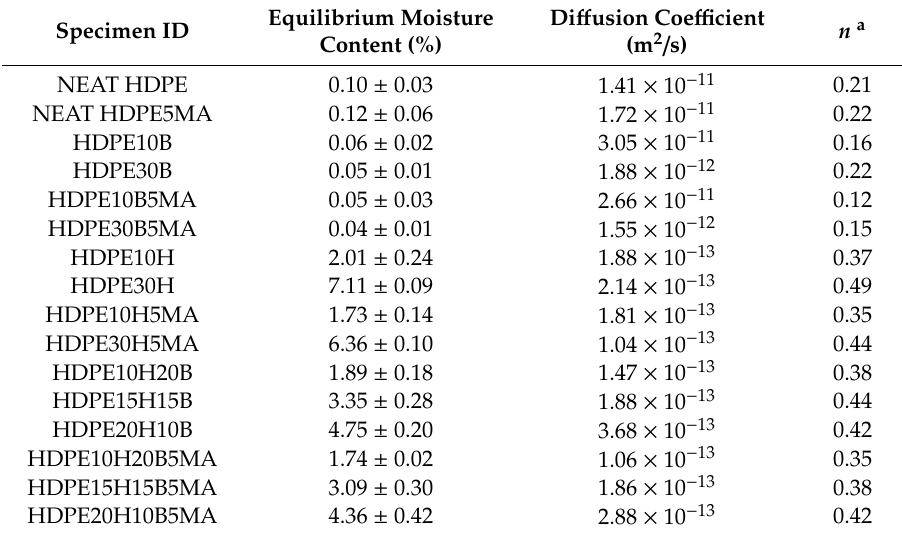
Table 3. Summary of water absorption parameters for basalt / hemp